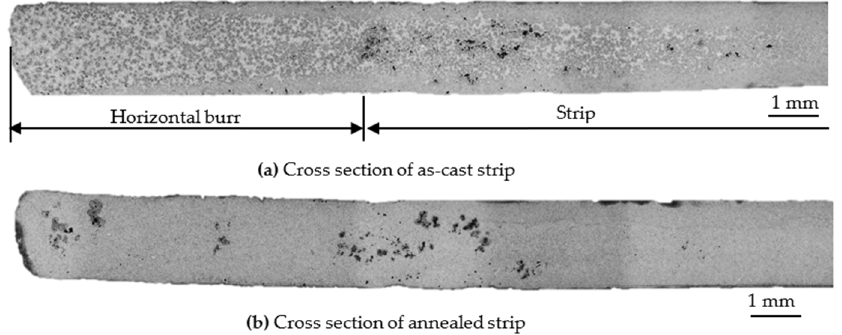
Figure 12. Cross section of the horizontal burr of A383 strip cast at a roll speed of 30 m/min.